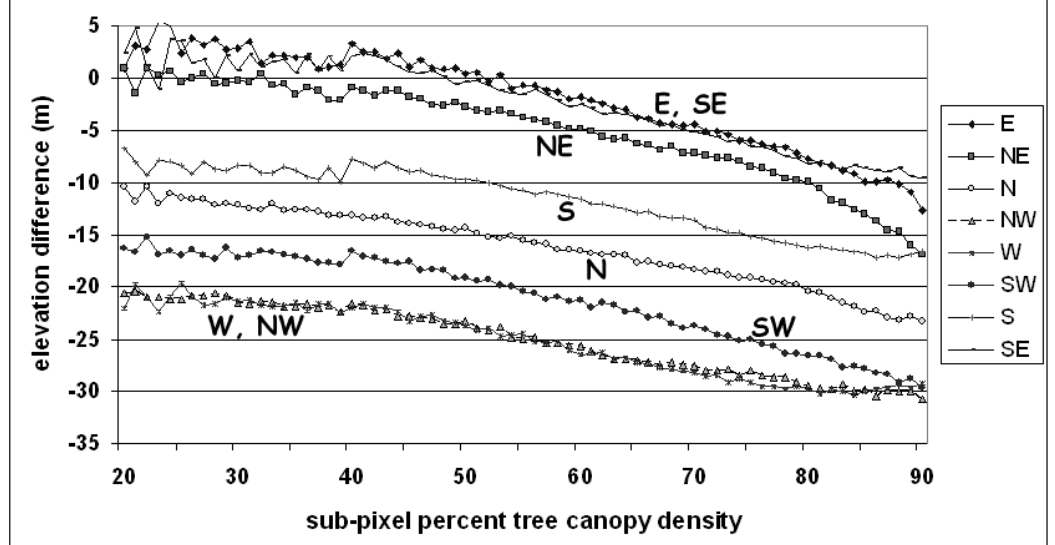
Figure 9. The mean elevation difference versus 1% interval of sub-pixel percent tree canopy density per geographic